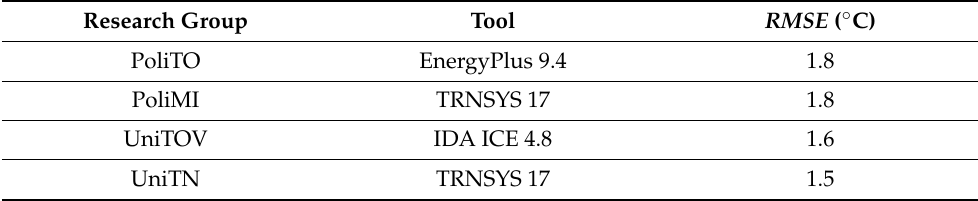
Table 5. Baseline model’s performance (October